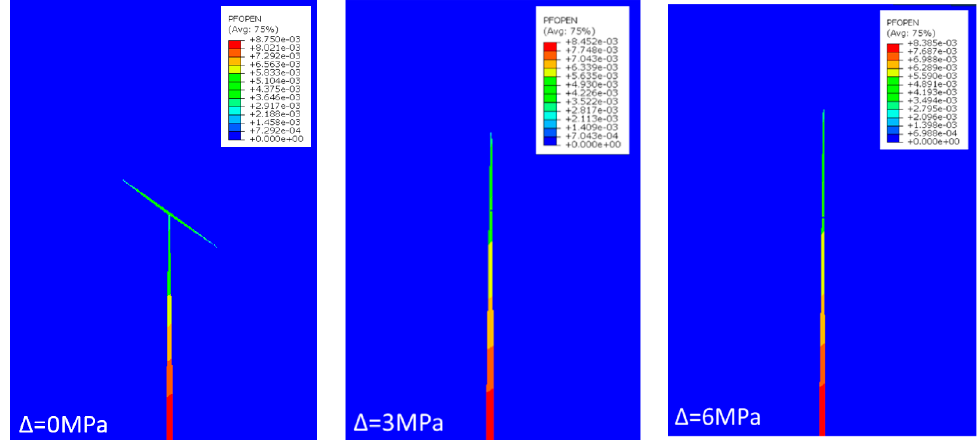
Figure 6. Crack geometry under different in situ stress.